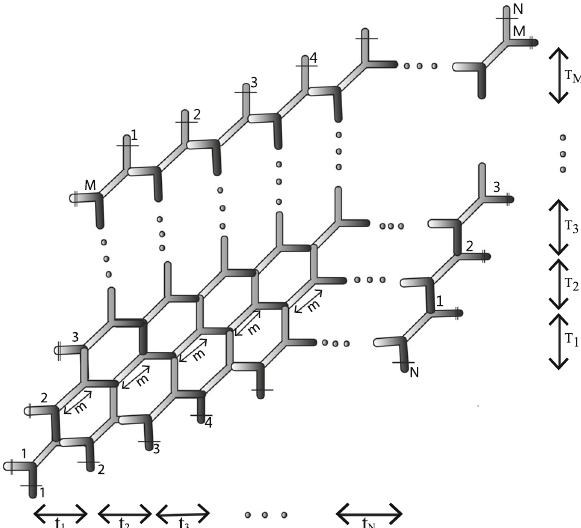
Fig. 2 Web diagram of X N , M . t i ∈ { t 1 ,..., t N } denotes the distance between i thand i + 1-tlinesand T i ∈ { T 1 ,..., T M } denotesthedistance between i -th and i + 1th lines. m denotes the Kähler parameter of the diagonal P 1 s. The double and single bars | and − indicate the periodic